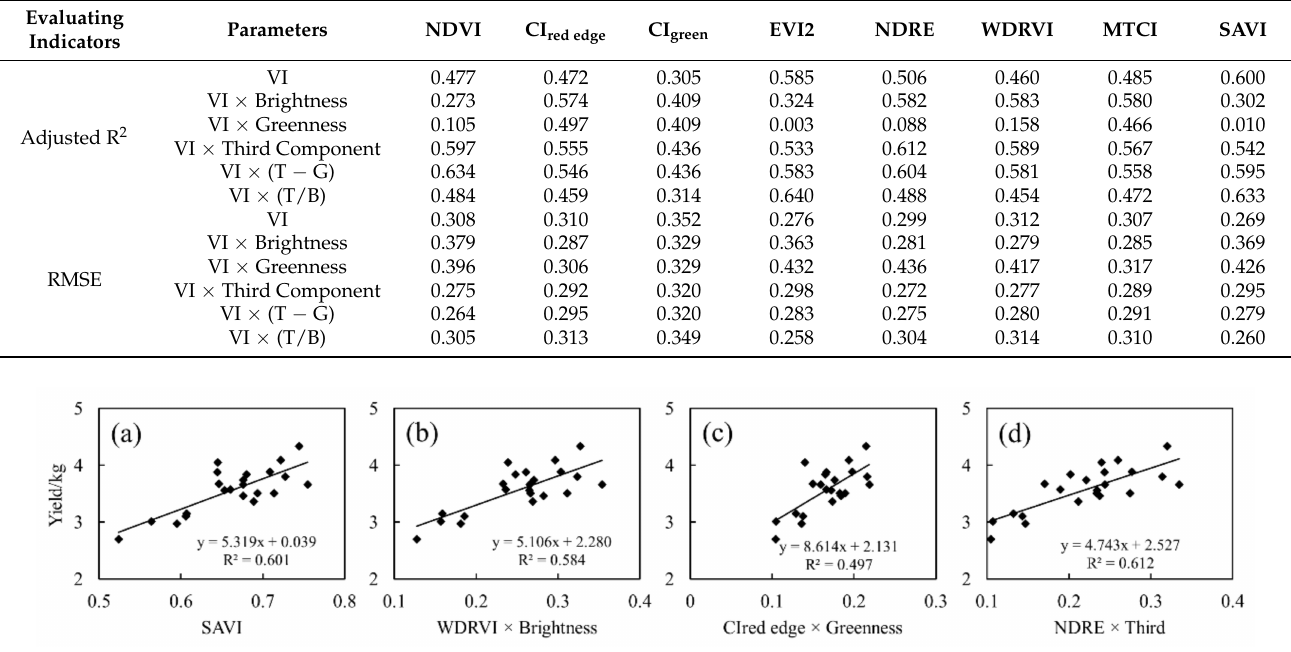
Table 5. Yield-estimation models incorporating TCT parameters and VIs at the heading stage.